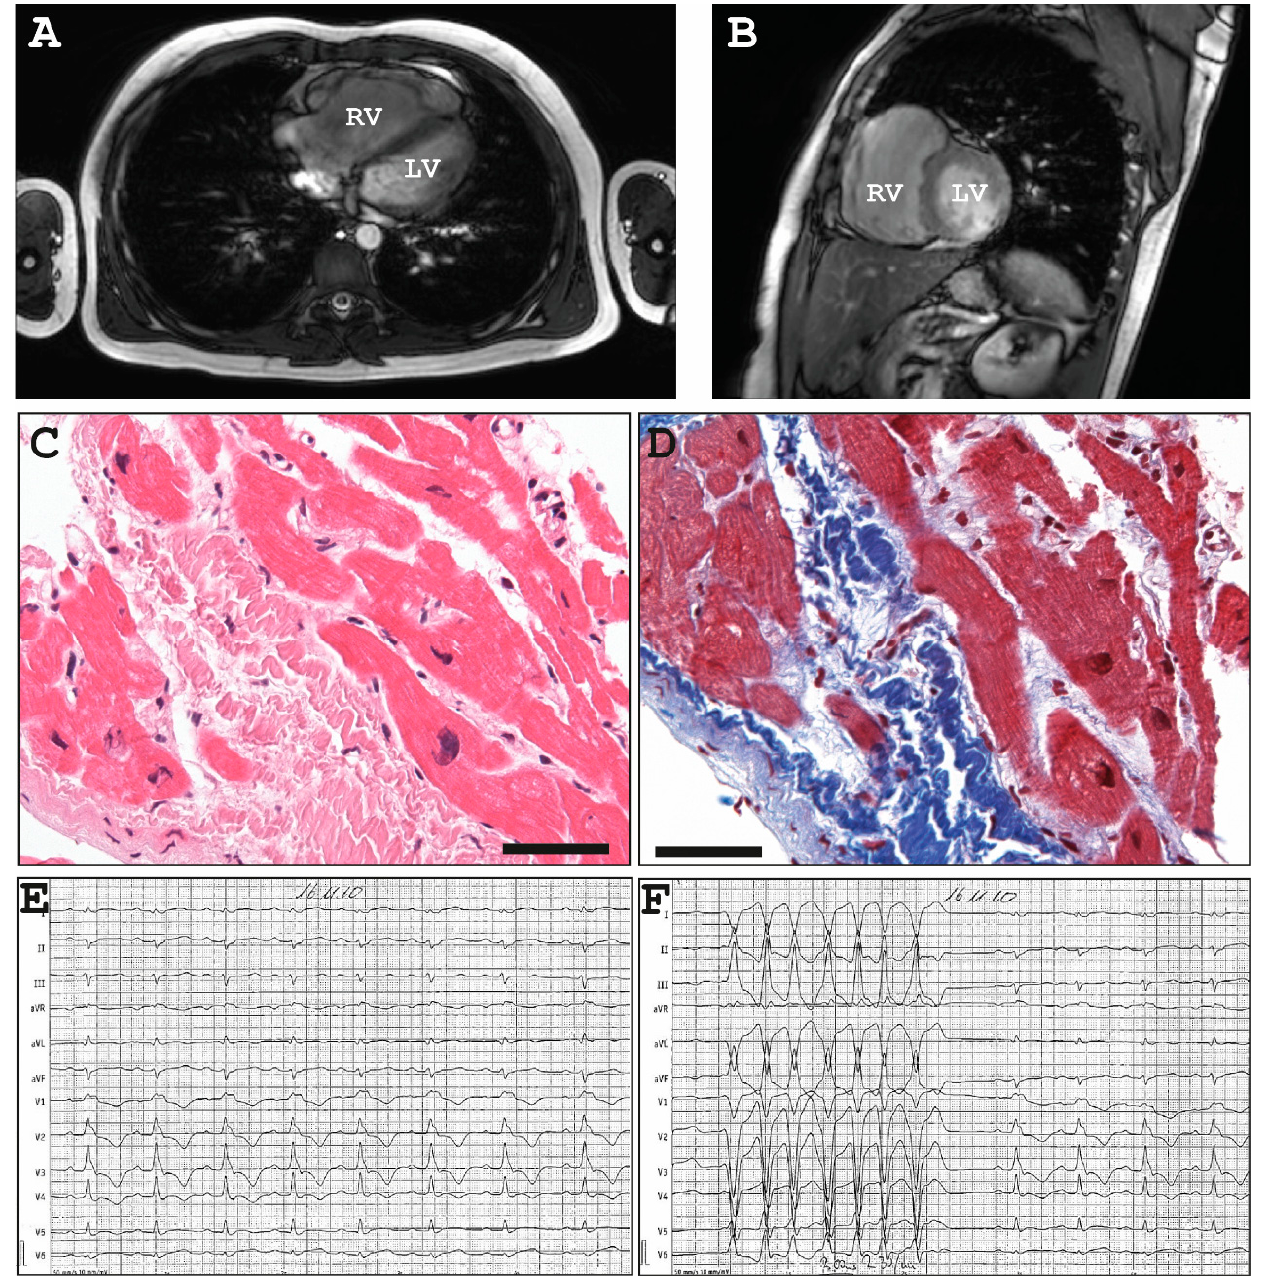
Figure 2. Clinical data of II-I, Family A. ( A,B ) Cardiac magnetic resonance imaging (MRI) revealed a dilated right ventricle with reduced global function and segmental bulging. Hematoxylin and eosin ( C ) and trichrome staining ( D ) of a right- ventricular biopsy revealed subendocardial fibrosis and degeneration of cardiomyocytes. Scale bars represent 50 µm. ( E,F ) Right axis deviation, at the age of 12 years still incomplete, later complete right bundle branch block, inverted T-waves in the right precordial leads and non-sustained ventricular tachycardia were present in the 12-lead electrocardiogram (ECG).